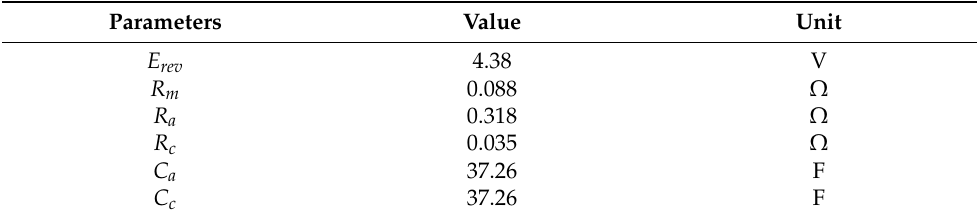
Table 2. Values of the estimated parameters for the PEM electrolyzer emulator.